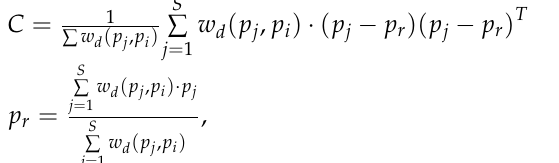
neighbors of the current point to their one respective neighbor. The estimated normal at p i is the eigenvector associated with the smallest eigenvalue of the covariance matrix. Figure 2 shows the normal estimation errors of PCA, WPCA, and NERL on the Harpago and Scallop curved surface models.